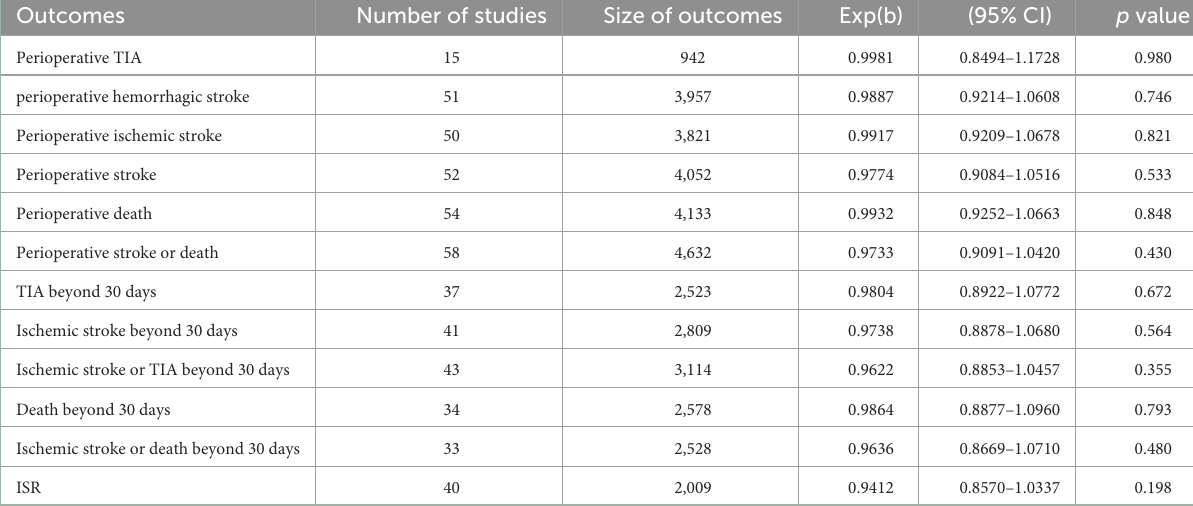
TABLE 6 Univariate meta-regression analyses based on stent variety.